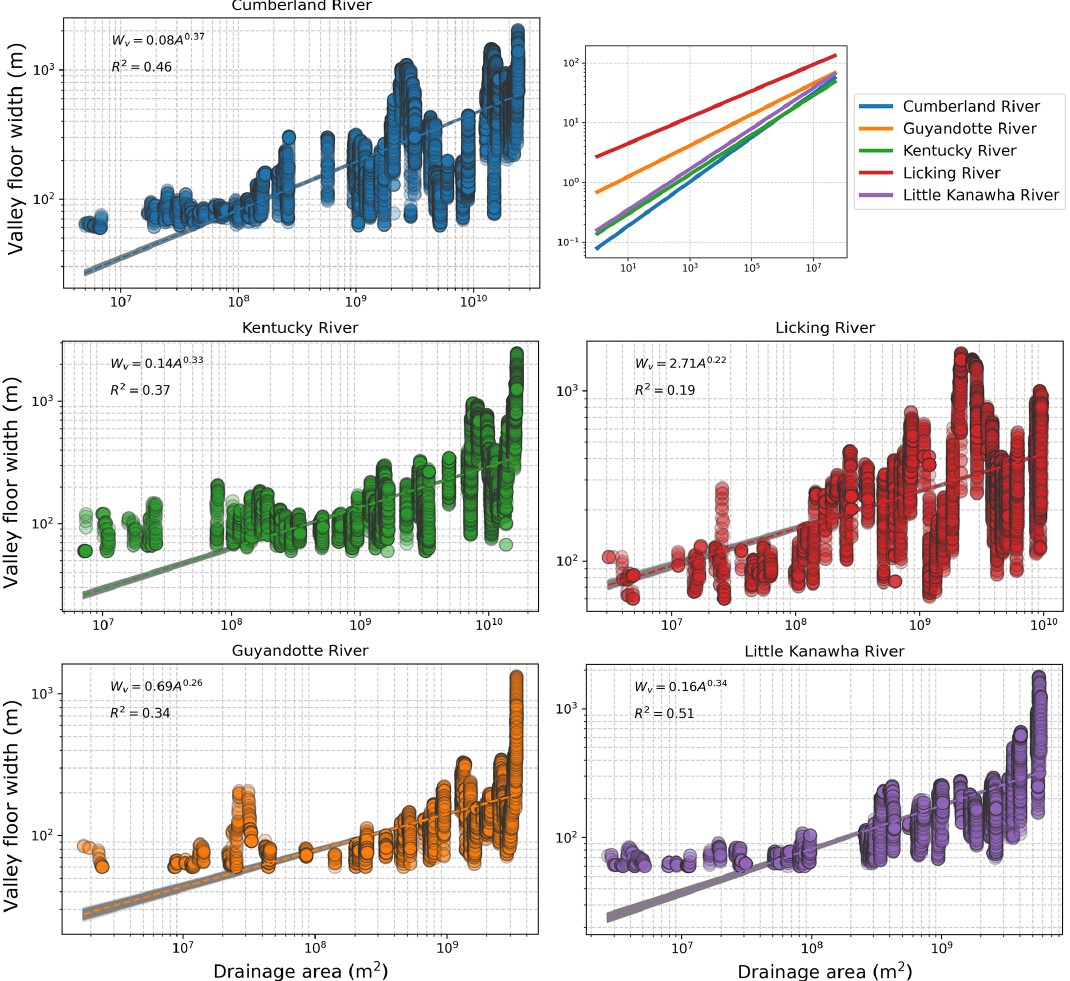
Figure 13. Width–area analysis for large rivers in the Appalachian Plateau, Kentucky and West Virginia, USA. Example width–area plots are shown for each river along with a compiled plot of the fitted power laws for each river in the top left. The grey bars represent confidence intervals on the regressions, calculated by bootstrapping the data 1000 times with a 50% sample